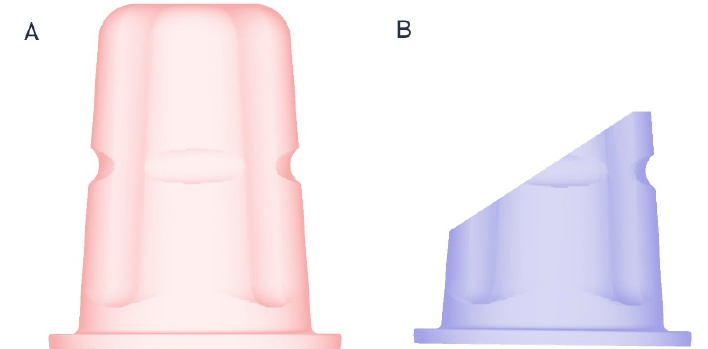
Figure 2. ( A ) Reconstruction tool for unmodified implants (OC 1,2 ); ( B ) reconstruction tool for intraorally adjusted (OC 3,4 ) implants.